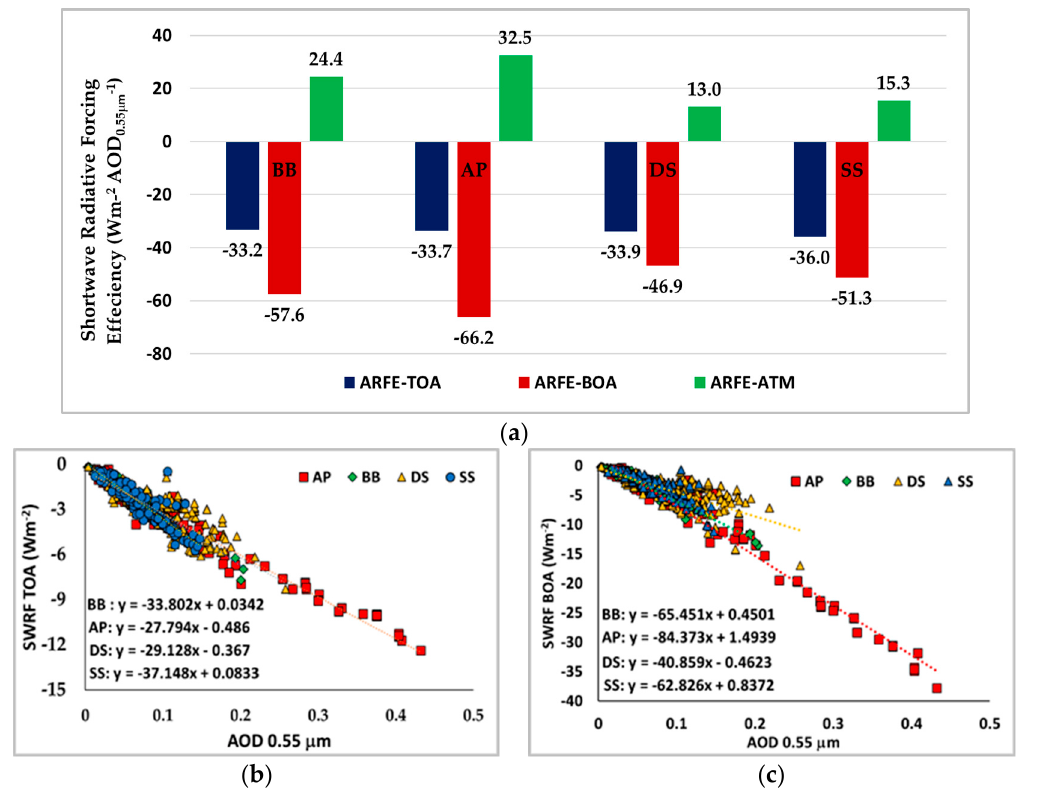
Figure 7. The shortwave aerosol radiative forcing efficiency of each aerosol species ( a ), and the relationship between the shortwave aerosol radiative forcing efficiency (SWARFE) and AOD 0.55µm at the top of the atmosphere (TOA) ( b ) and the bottom of the atmosphere (BOA) ( c ).